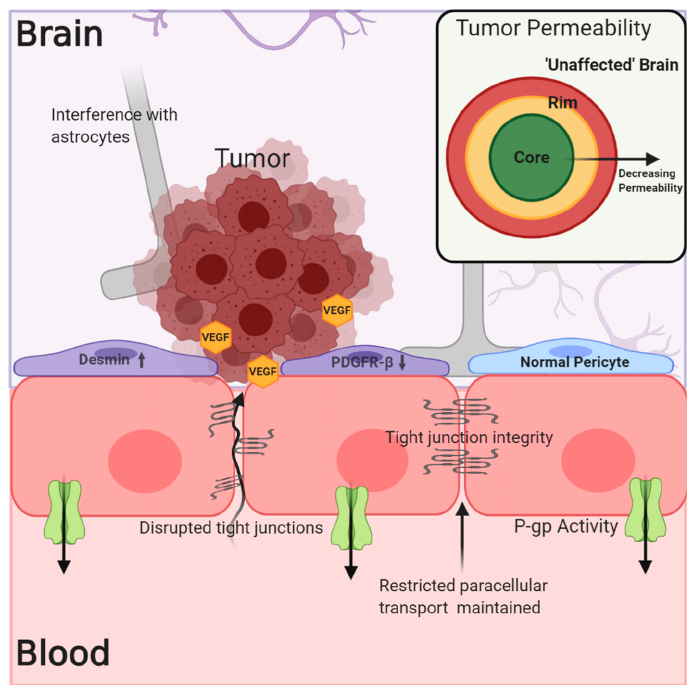
Figure 2. The blood–tumor barrier (BTB) is characterized by increased cytokine and VEGF signaling from the tumor, which may lead to decreased expression of tight junction (TJ) proteins like claudin-5. Alterations in pericyte phenotype and disruption of astrocytic associations with endothelial cells may contribute to decreased barrier integrity. However, this is not a uniform phenomenon within or among tumors, and the expression of efflux transporters limits drug permeation into the tumor. Evidence exists showing decreased permeability of the BTB in regions distant to the core of the tumor, which more closely resemble “unaffected” brain.